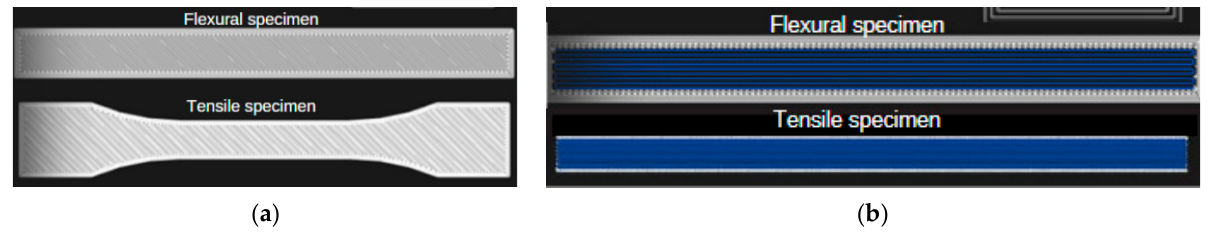
Figure 2. 2D printing direction samples manufactured by CFF technology extracted from Eiger software: ( a ) ONYX; ( b ) continuous carbon-fiber-reinforced ONYX. Table 1. Reinforced ONYX Specimen printing parameters.